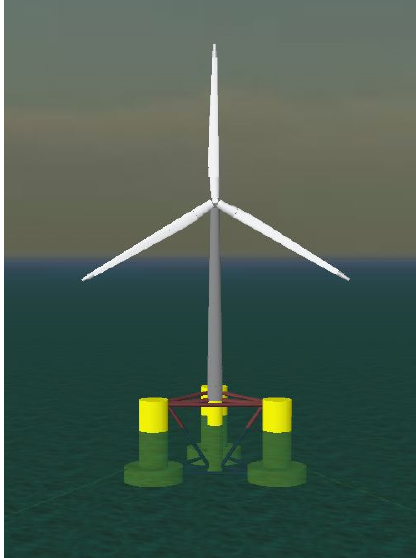
Figure 1. 3D view of the given OrcaFlex task.